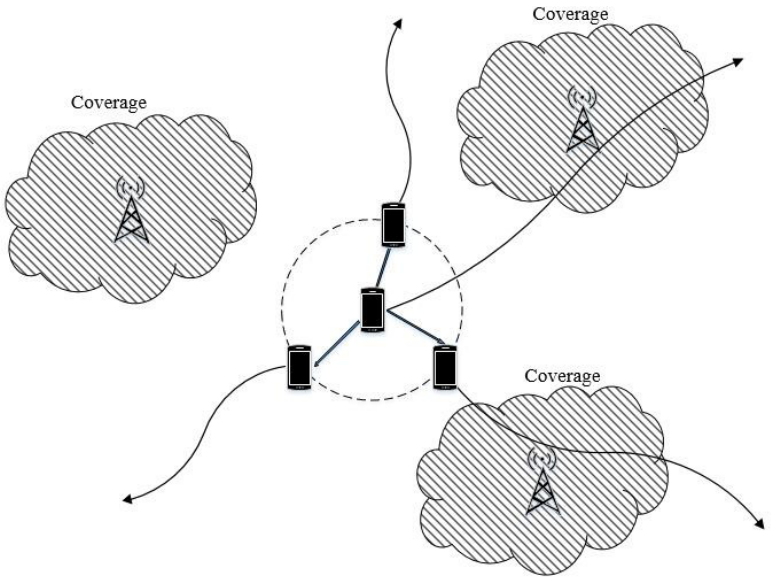
Figure 1. System model of the hybrid ad hoc network with user collaboration and coverage